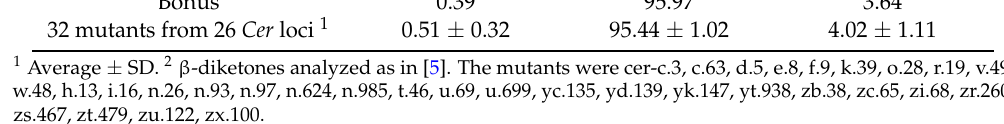
Table 4. Chain length distributions 1 of wild type Bonus and cer mutant β -diketones 2 . C 29 Bonus 0.39 95.97